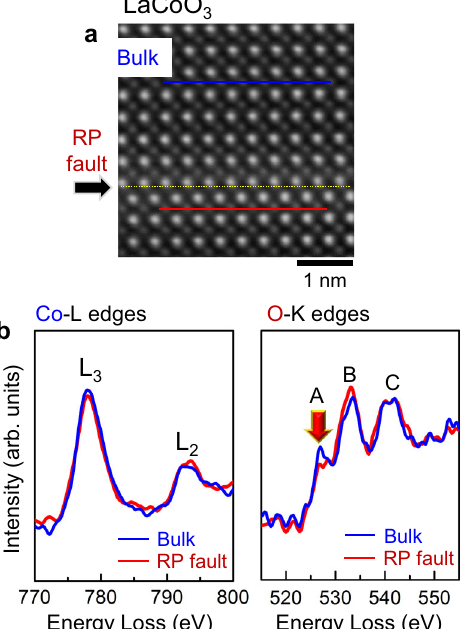
Fig. 4 EELS analysis at the RP fault in LaCoO 3 . a As indicated in the image, Co- L and O- K edges were acquired from the bulk (blue line) and the RP fault (red line) in LaCoO 3 . b Three major peaks in the O K -edges represent the hybridizations of O 2 p with Co 3 d (A), La 5 d (B), and Co 4 s /4 p (C) orbitals, respectively. No noticeable peak shift or intensity variation is observed in the Co- L edges, showing the invariant oxidation states of Co 3 + at the fault plane. A red arrow in the plot of O- K edges indicates the intensity reduction of peak A at the fault (red curves), whereas the intensities of peaks B and C hardly vary between the bulk and the